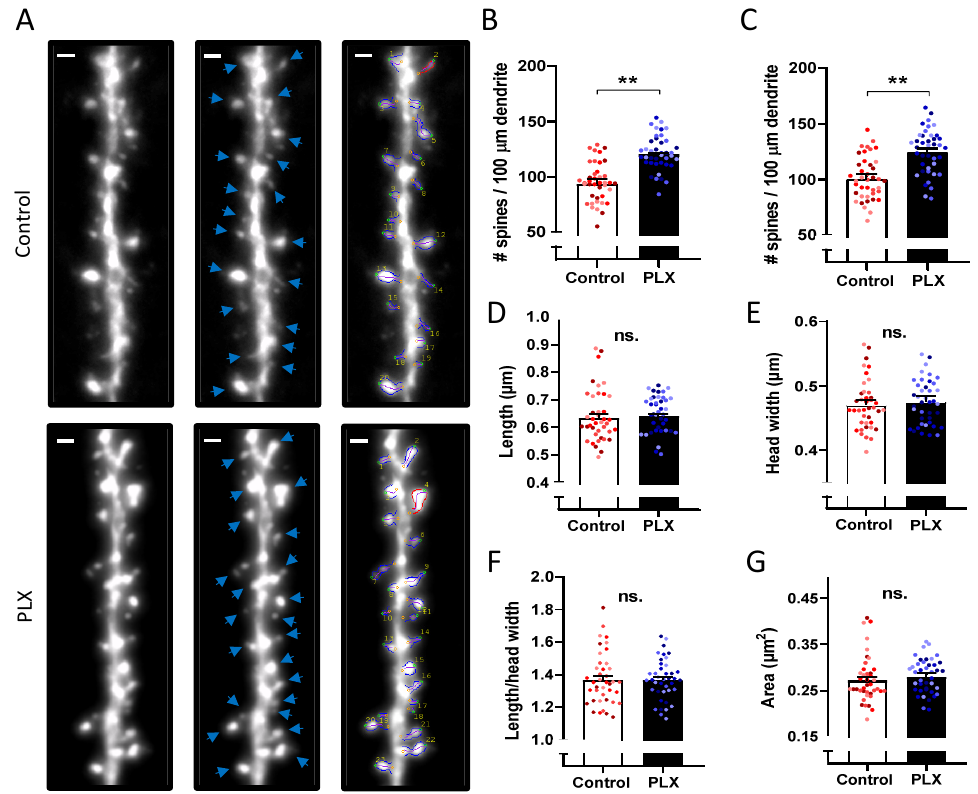
Figure 5. Increased spine density after depletion of microglia. ( A ) Representative 63 × images of hippocampal secondary dendrites of control and PLX-treated animals in str. radiatum . Scale bar, 1 µ m. ( B – G ) Quantification of spine morphology and density. Statistical analysis was performed using a nested t-test. Bars and error bars represent mean ± SEM values per animal. Single points on bars represent average values per cell, colors indicate cells from the same animal. After microglia depletion, the spine density is significantly higher as shown in ( B ) for the 2D analysis (** p = 0.0023) as well as in ( C ) for the 3D analysis (** p = 0.0087). ( D – G ) Quantification of spine morphology parameters revealed no differences between